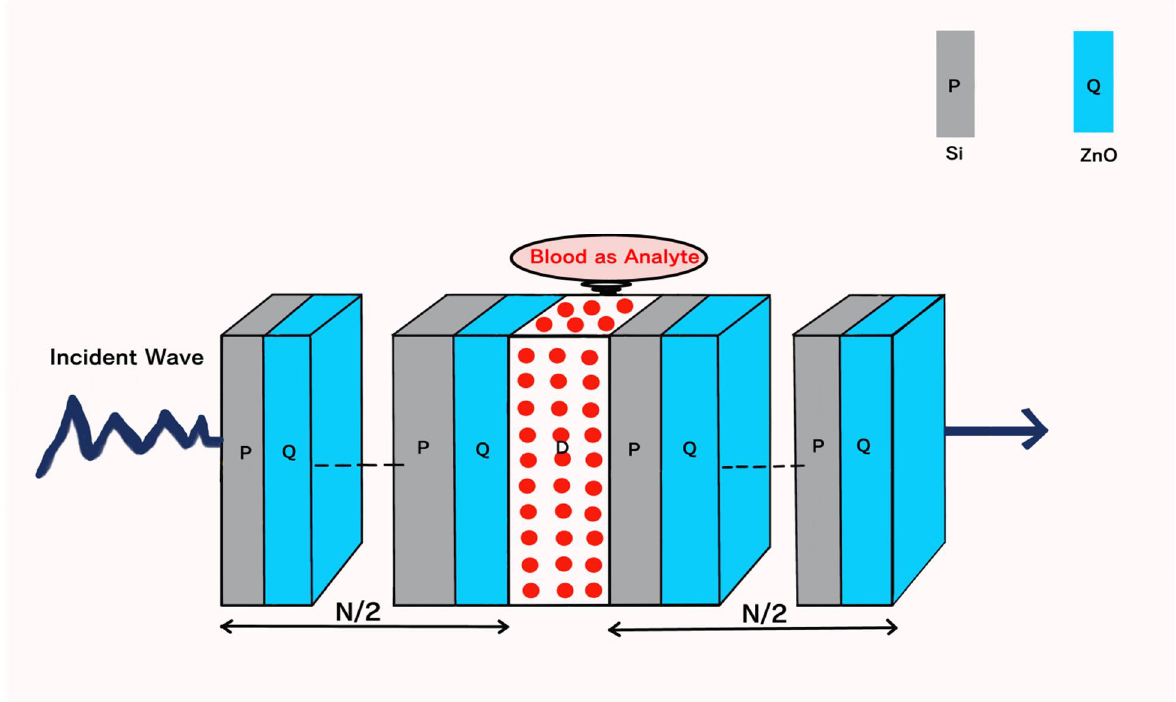
Figure 1. Pictorial representation of the proposed biophotonic sensor composed of 1D PC with a defect. Here, letters P, Q, and D are used to represent Si, ZnO, and sample layers, respectively.